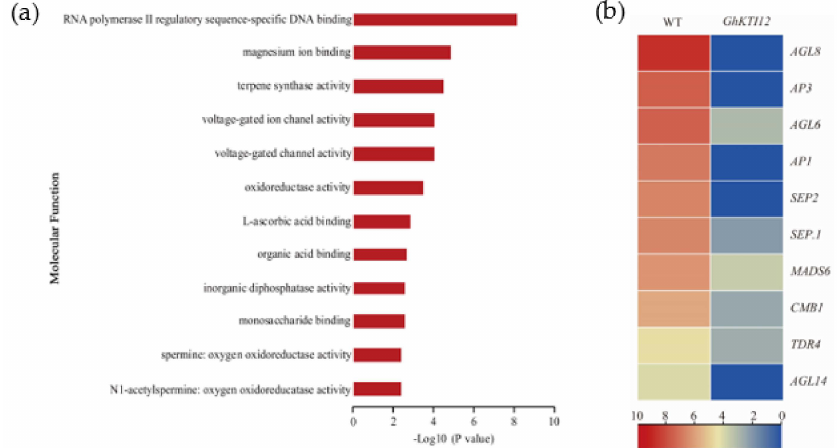
Figure 7. Analysis of downregulated gene related to plant flowering in GhKTI12 transgenic plants. ( a ) Top 12 GO enrichment analysis of downregulated genes (DRGs) in molecular function. ( b ) The heat map of DGEs associated with flowering time related